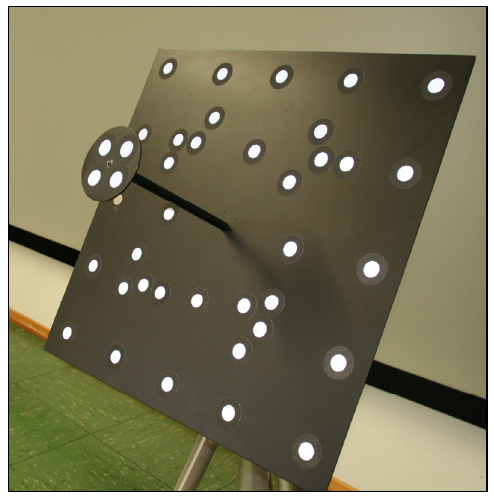
Fig 1 . The test-field of camera calibration Parameters of camera calibration are obtained after calculation of polynomials (1,